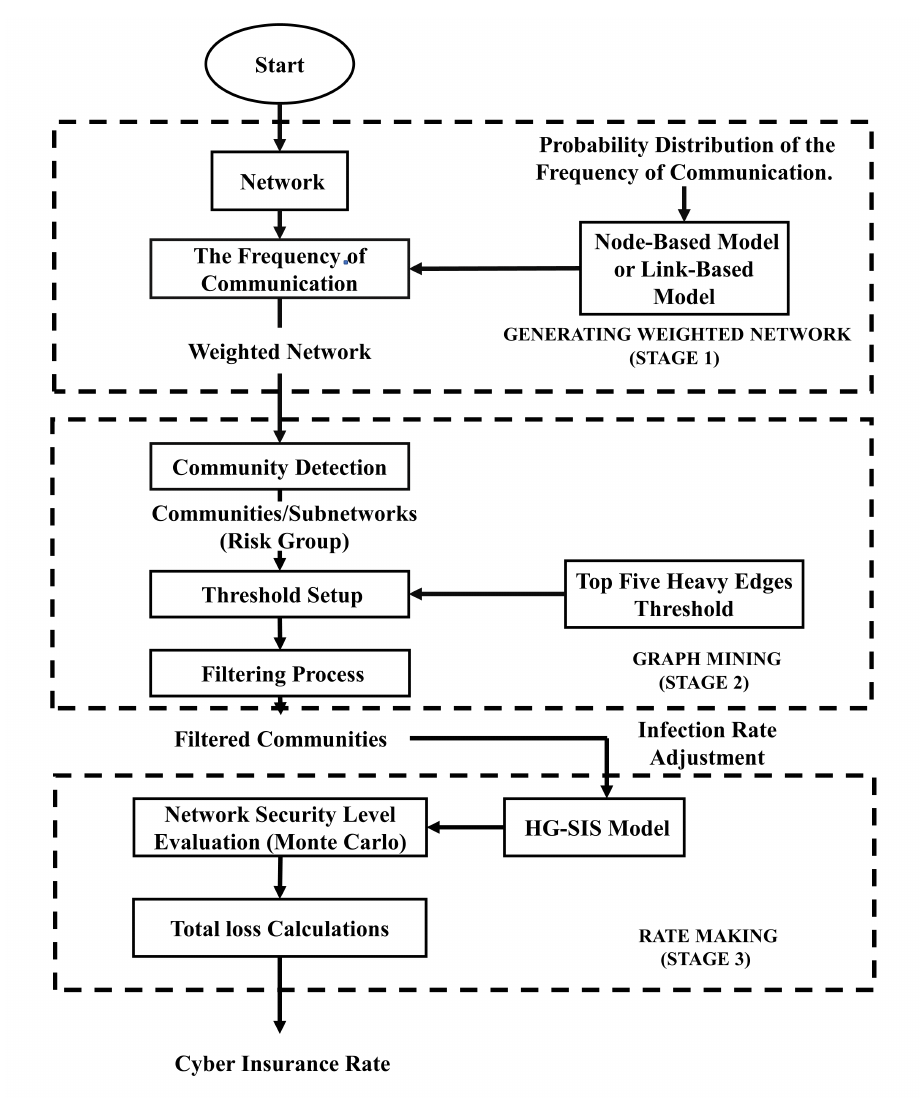
Figure 1. Graph mining approach (GMA) used for cyber insurance ratemaking